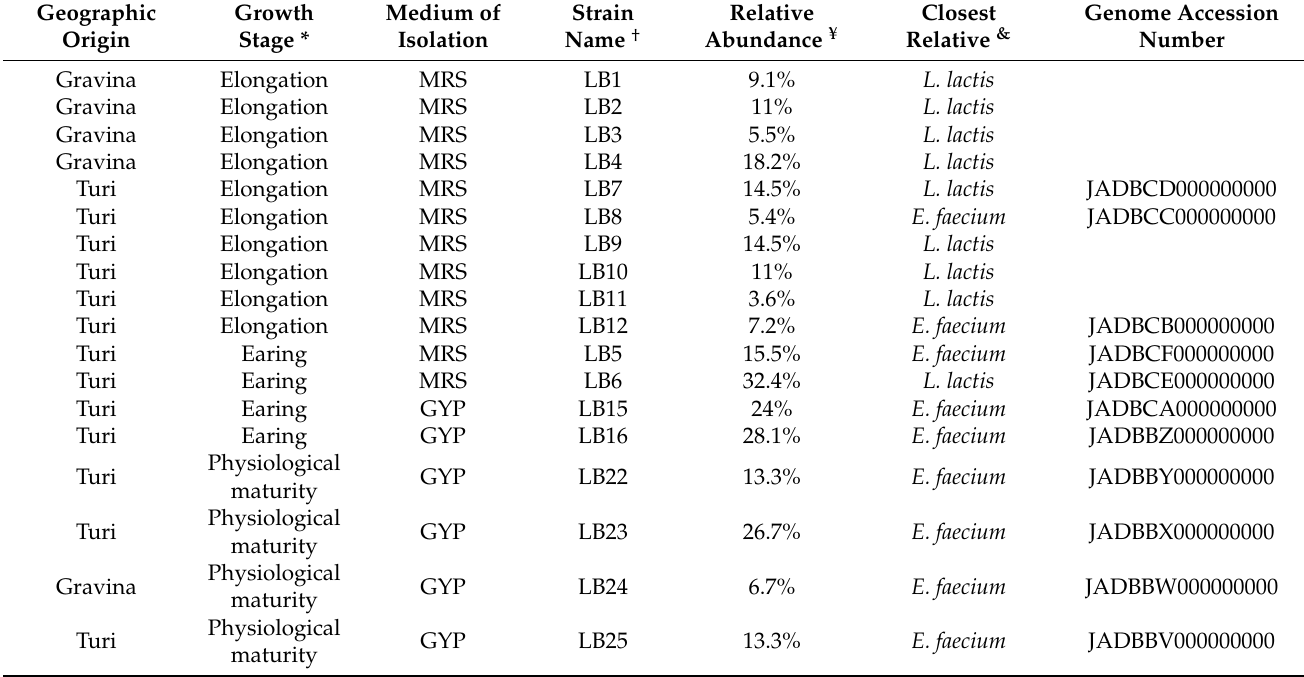
Table 1. Lactic acid bacteria isolated from wheat rhizopsheric soil collected from two different experimental sites during three different growth